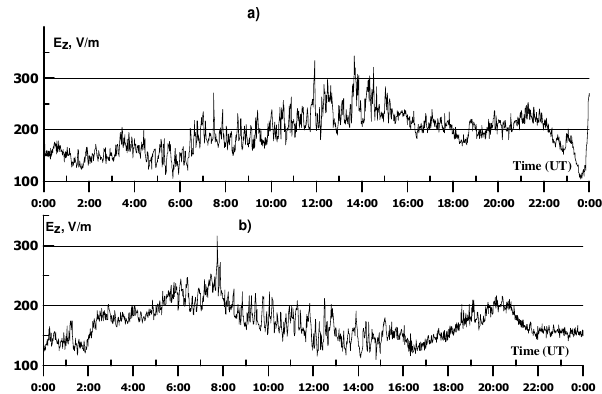
Fig. 2. Electric field observation records of 23 July 2012 (a) and 30 July 2012 (b)